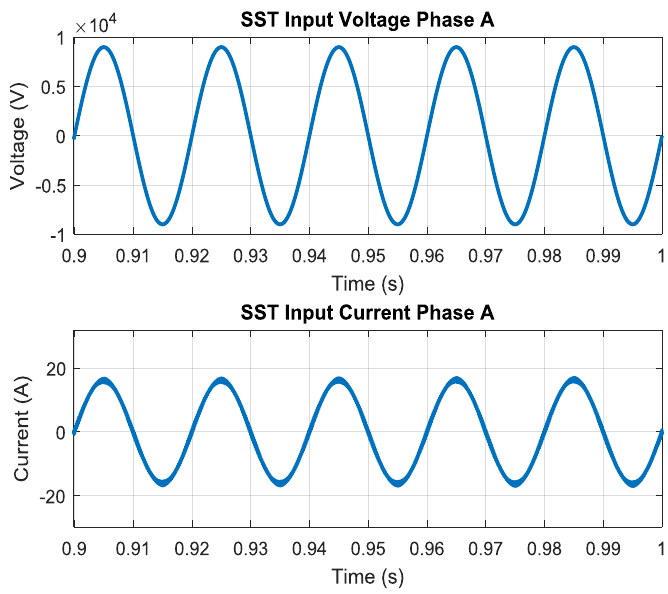
Figure 9. Result displaying that phase A voltage and current are in phase with each other.